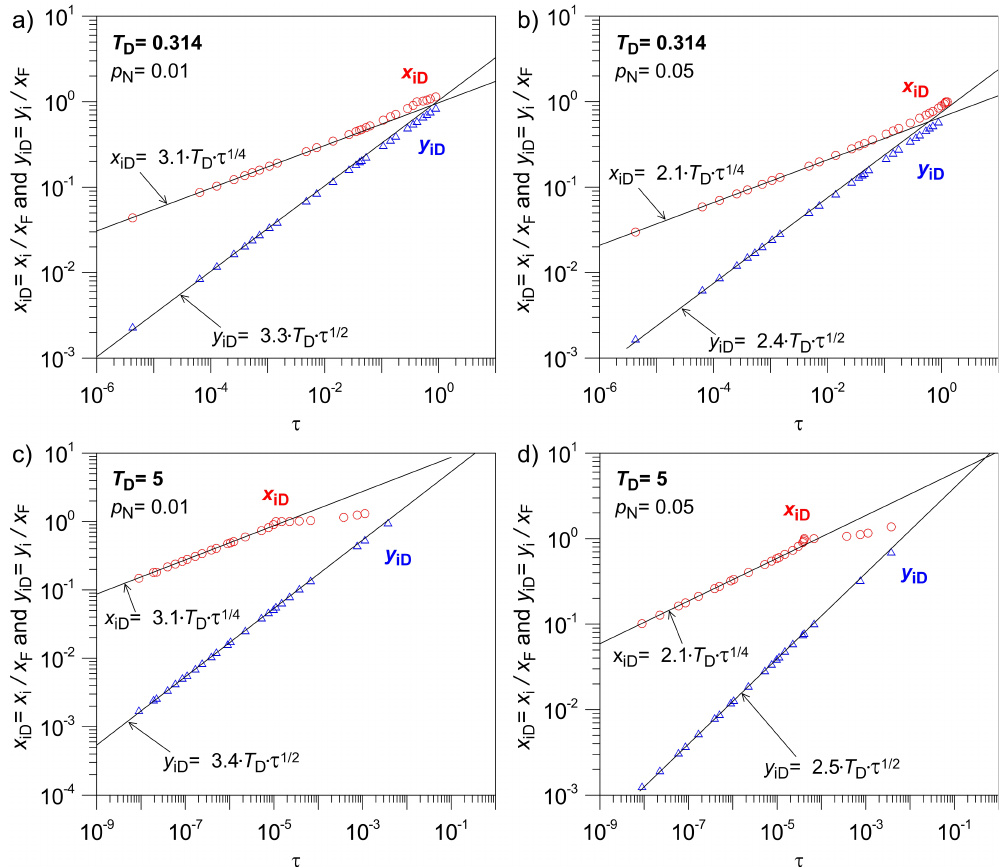
Fig. 4. Dimensionless distances x iD and y iD of isobars of normalized pressure p N along the x D and y D axis as a function of dimensionless time for (a) T D = 0 . 314, p N = 0 . 01; (b) T D = 0 . 314, p N = 0 . 05; (c) T D = 5, p N = 0 . 01; and (d) T D = 5, p N = 0 . 05.